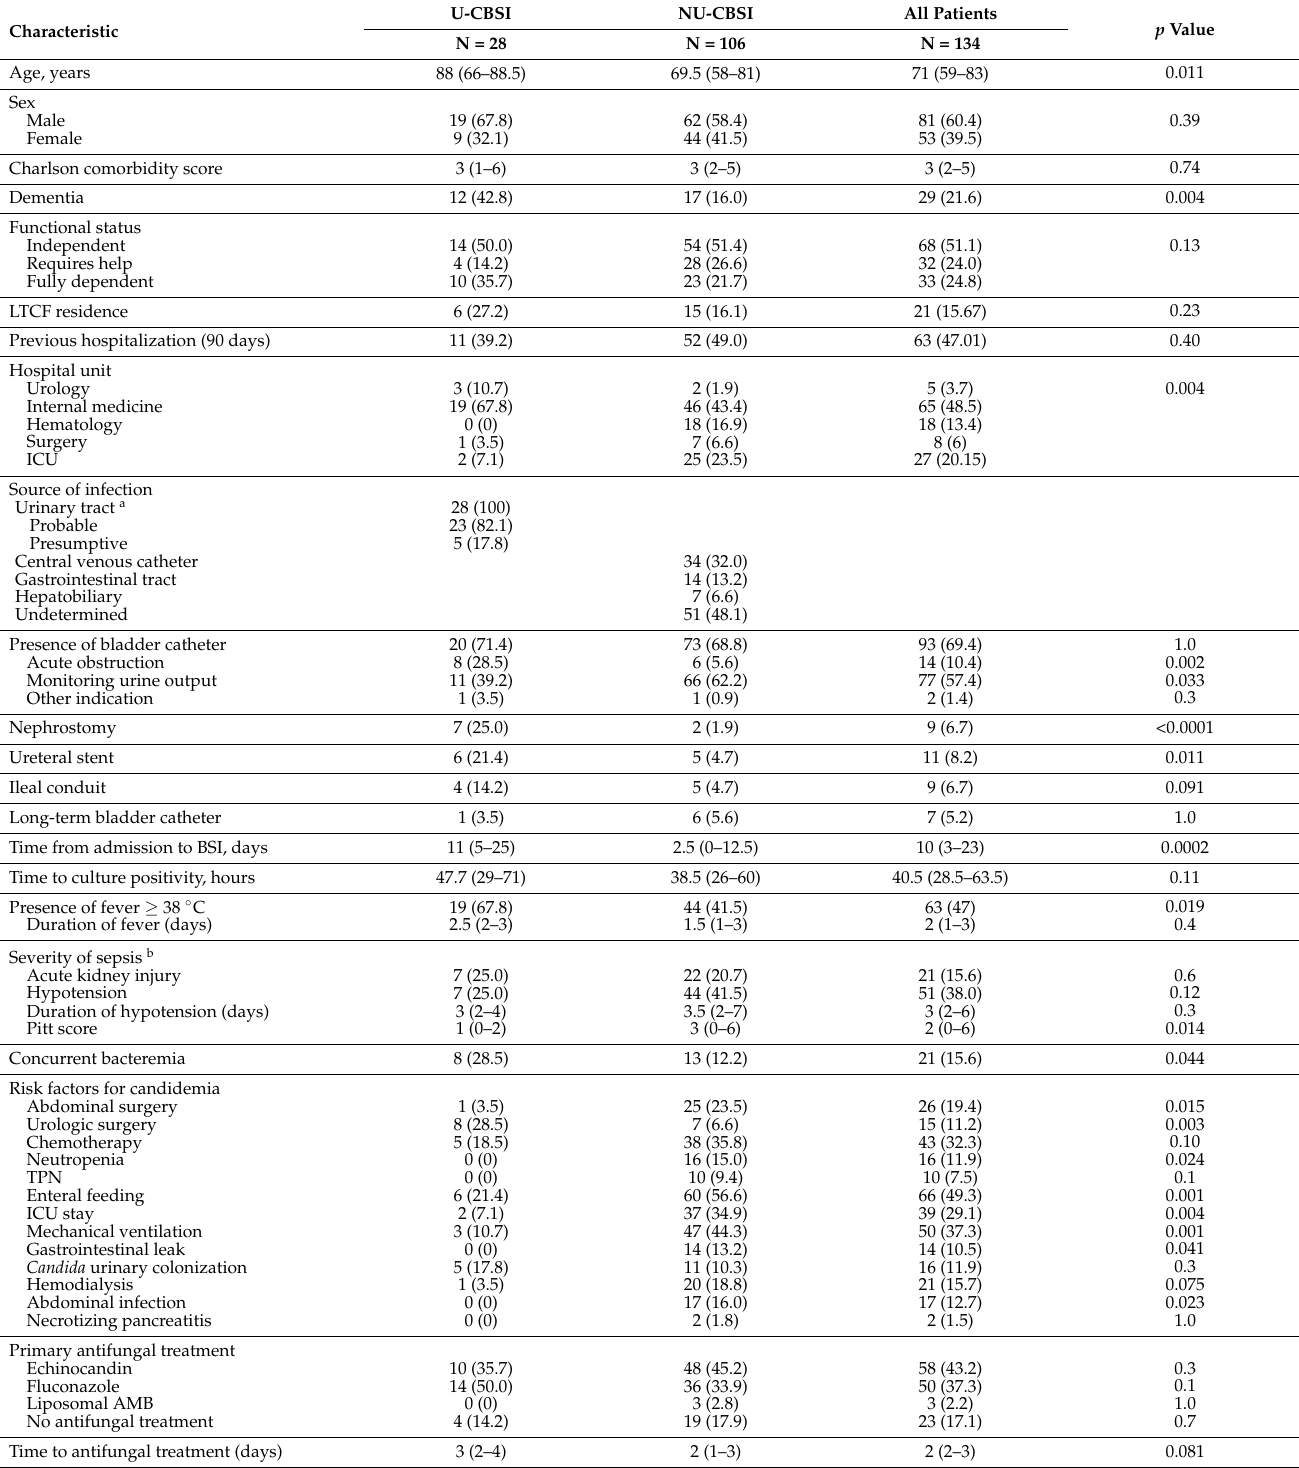
Table S1. b Assessed during 72 h after the onset of